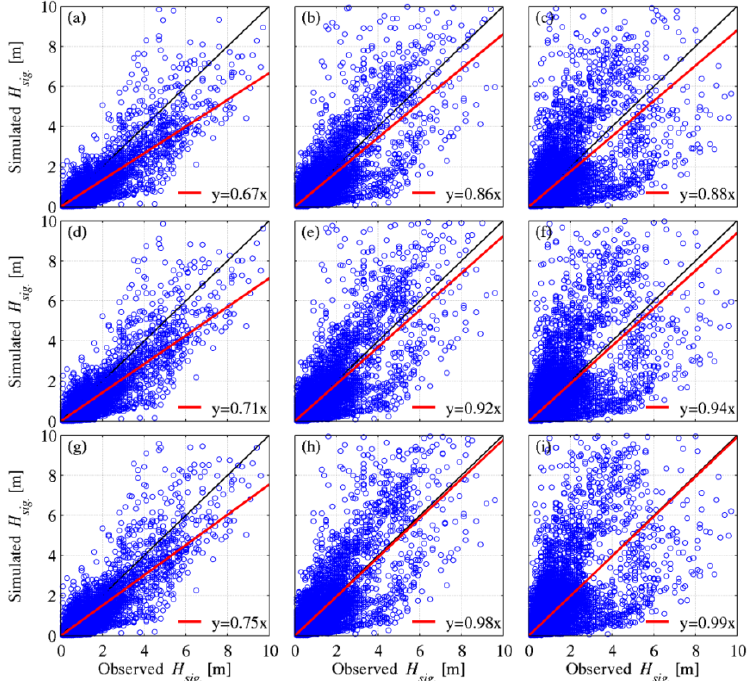
Figure 5. Comparison of the simulated and observed significant wave heights based on experimental conditions of the numerical model. ( a ) Case03 (+00 h); ( b ) Case03 (+06 h); ( c ) Case03 (+12 h); ( d ) Case04 (+00 h); ( e ) Case04 (+06 h); ( f ) Case04 (+12 h); ( g ) Case05 (+00 h); ( h ) Case05 (+06 h); ( i ) Case05 (+12 h).